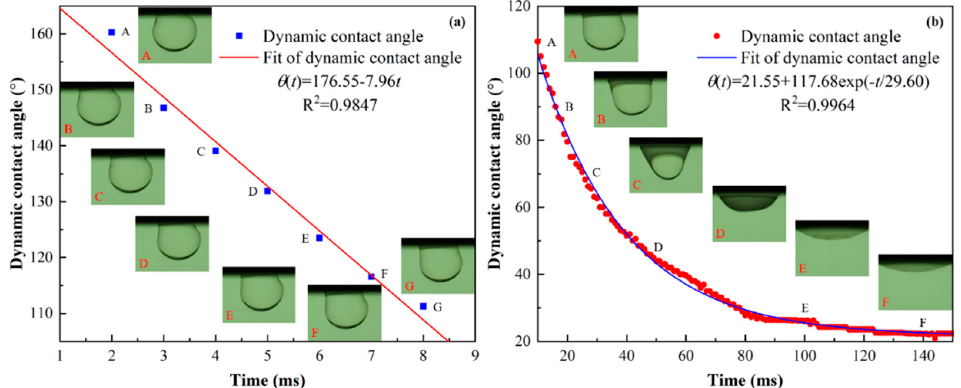
Figure 5. Variation of dynamic contact angle with time at different time scales during the oil droplet spreading on the Teflon in deionized water. ( a ) t < 10 ms and ( b ) 10 ms ≤ t ≤ 150 ms. Note that the scattered dots represent the experimental data, and the solid lines represent the fitting results. The insets correspond to the profiles of an oil droplet at specific